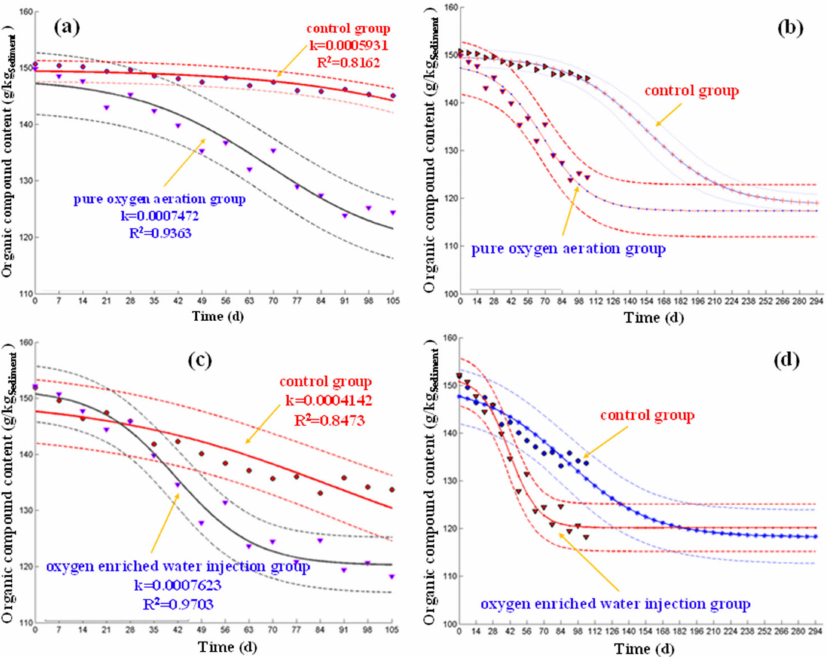
Figure 6. ( a ) The fitting model and ( b ) prediction of organic compound content in sediment during pure oxygen aeration treatment; ( c ) the fitting model and ( d ) prediction of organic compound content in sediment during oxygen enriched water injection